Question: What form of chart is displayed?
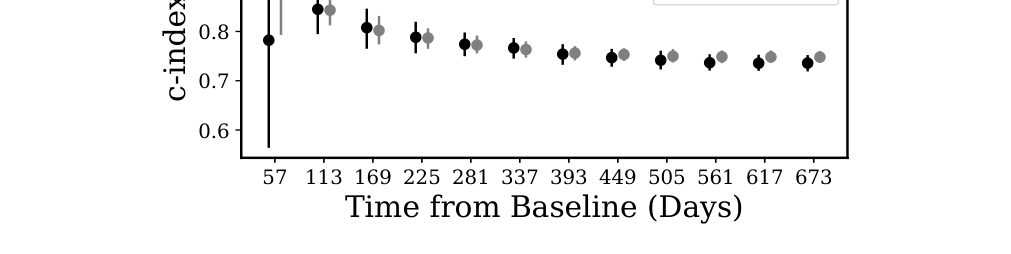
Answer: survival